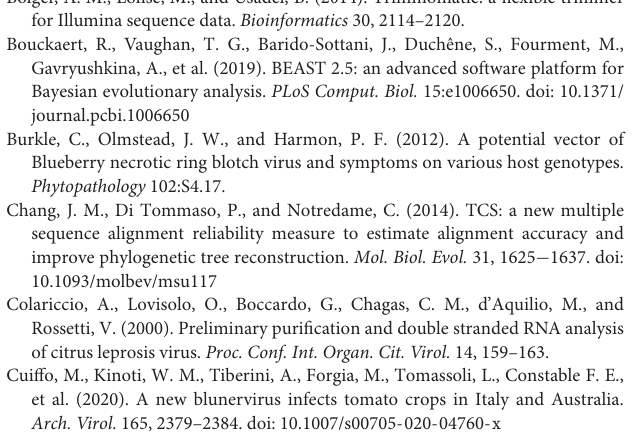
Supplementary Figure 5 | Agarose gel electrophoresis of 28S rRNA, hibiscus yellow blotch (HYBV) RNA 1 and RNA 2 amplicons using direct RT-PCR (dRT-PCR) assays described by Druciarek et al. (2019). dRT-PCR assays were performed on four individual Brevipalpus mites (B1–B4) collected from a HYBV-infected Hibiscus rosa-sinensis plant. Upper panel: 28S rRNA and HYBV-RNA 1 amplicons were amplified using primer sets D1D2w2/28Sr0990 and HYBV-RdRp-F/R with expected amplicon sizes of ∼ 700 and 223 bp, respectively. Bottom panel: HYBV-RNA 1 and RNA2 amplicons were amplified using primer sets HYBV-p10-F/R and HYBV-p33-F/R with expected amplicons of 210 and 438 bp, respectively. A non-template control (N) was included in all the assays. Sanger sequencing of the 28S rRNA amplicon later suggested mites B1 and B2 were B. yothersi , while the identity of mites B3 and B4 was ambiguous. DNA ladder is 100 bp (Thermo Fisher), and sizes of select fragments are provided in base pairs (bp). Supplementary Figure 6 | Leaves collected from symptomatic Hibiscus spp. plants growing with 1.6 km of the hibiscus yellow blotch virus (HYBV)-infected H. rosa-sinensis plant. Samples A, B, and D tested positive for HYBV using RT-PCR, whereas Samples C, E, and F tested negative. Sample A also tested positive for citrus leprosis virus C2 by RT-PCR. None of the samples (A–F) tested positive for hibiscus green spot virus 2 by RT-PCR. Supplementary Figure 7 | Detection of hibiscus yellow blotch virus (HYBV), citrus leprosis virus C2 (CiLV-C2), and hibiscus green spot virus 2 (HGSV2) in Hibiscus spp. samples by RT-qPCR and RT-PCR assays. Six samples (A–F) of Hibiscus spp. ( Supplementary Figure 3 ) collected within 1.6 km of the HYBV-infected H. rosa-sinensis underwent both assays using HYBV-RdRp-F/R (main text), CiLV-C2-RdRp-F/R and HGSV2-RdRp-F/R ( Supplementary Table 1 ) for virus detection. Samples A, B, and D tested positive for HYBV in both one-step RT-qPCR (A) and two-step RT-PCR (B) assays. Due to similar amplification curve of samples A (dark red), B (blue), and D (light green), individual amplification curves are provided for each sample and compared with a positive control (red). Sample A was the only CiLV-C2-positive sample in both one-step RT-qPCR (A) and two-step RT-PCR (B) assays. No samples tested positive for HGSV2. Expected size of amplicons for HYBV, CiLV-C2, and HGSV2 are 223 bp, 386 bp, and 227 bp, respectively. NTC and (N) represent non-template controls for (A) and (B) , respectively. The DNA ladder in panel (B) is the 100 bp Ladder from Thermo Fisher, and fragment sizes are provided at left in base pairs (bp). Supplementary Table 1 | Primers used in this study for 5 (cid:48) and 3 (cid:48) RACE, genomic sequence validation, and detection of hibiscus yellow blotch virus (HYBV). Primers used for the detection of citrus leprosis virus C2 (CiLV-C2) and hibiscus green spot virus 2 (HGSV-2) in one-step RT-qPCR assays are also provided. Supplementary Table 2 | Kitavirus intra-species nucleotide composition analysis of the 5 (cid:48) and 3 (cid:48) untranslated regions (UTR), and 5 (cid:48) and 3 (cid:48) conserved termini among the genomic segments of each virus